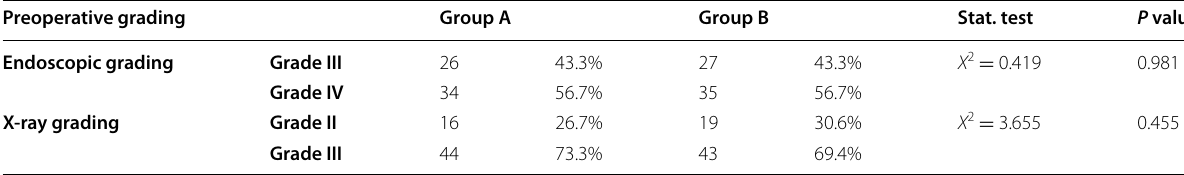
Table 2 Pre-operative endoscopic and radiological